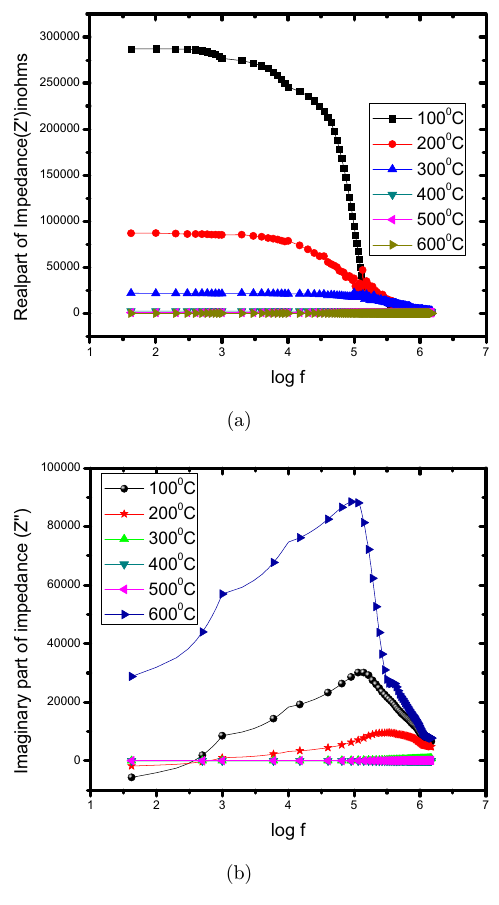
Fig. 4. (a) Frequency dependence of Z 0 of Pb 2 Sr 2 CaCu 2 O 9 at di®erent temperatures, (b) Frequency dependence of Z 00 of Pb 2 Sr 2 CaCu 2 O 9 at di®erent temperatures, (c) Frequency dependence of M 00 of Pb 2 Sr 2 CaCu 2 O 9 at di®erent temperatures, (d) Frequency dependence of M 00 of Pb 2 Sr 2 CaCu 2 O 9 at dif- ferent temperatures, (e) Frequency dependence of complex permittivity (cid:1) 00 of Pb 2 Sr 2 CaCu 2 O 9 at di®erent temperatures, (f) Cole – Cole plot of Pb 2 Sr 2 CaCu 2 O 9 , (g) and (h) Normalized imaginary parts of electrical modulus and impedance of Pb 2 Sr 2 CaCu 2 O 9 as a function of frequency and (i) The scaling behavior of M 00 at di®erent temperatures for Pb 2 Sr 2 CaCu 2 O 9 .